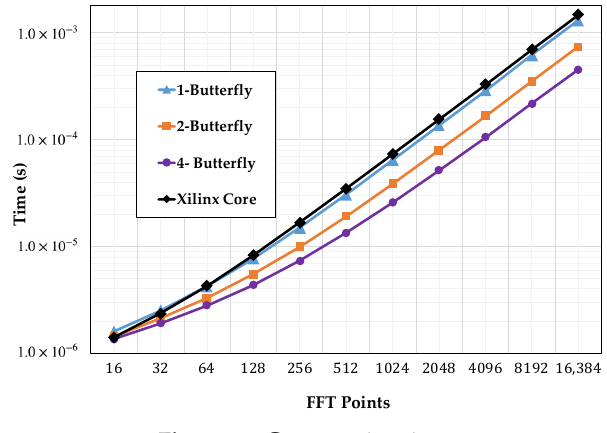
Figure 10. Computation